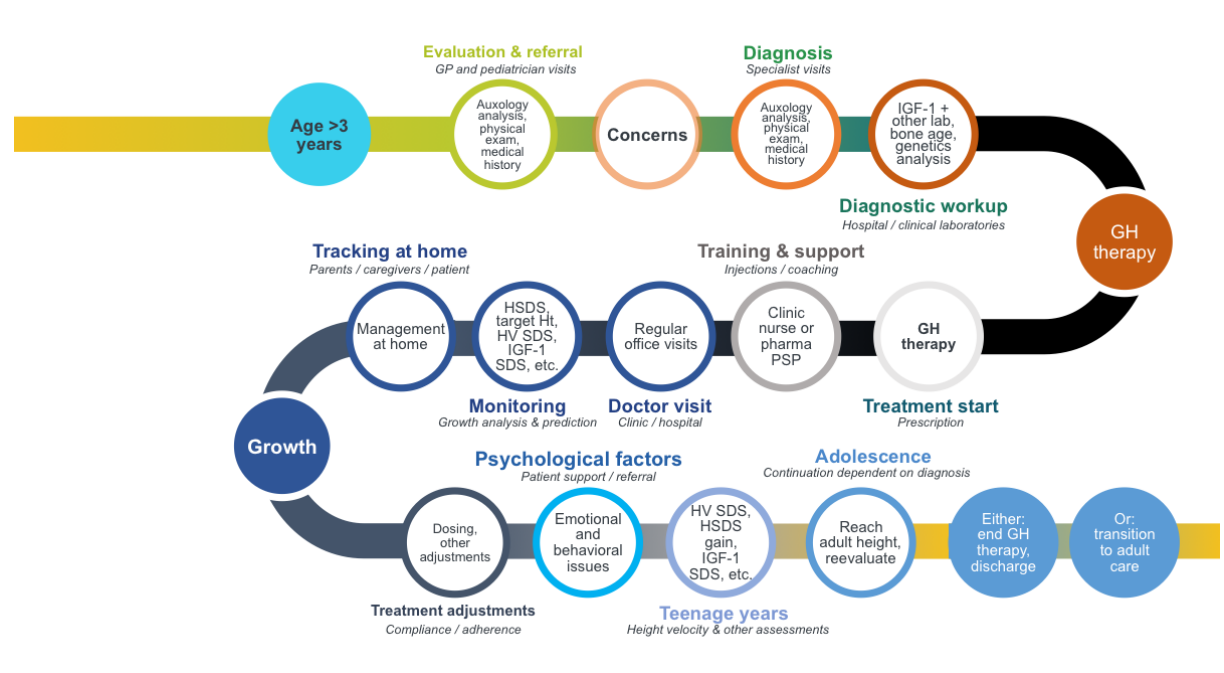
Figure 1. Patient journey for children with growth failure and those who receive growth hormone therapy. GH: growth hormone; GP: general practitioner; HSDS: height standard deviation score; Ht: height; HV: height velocity; IGF-1: insulin-like growth factor-1; PSP: pediatric specialist physician; SDS: standard deviation